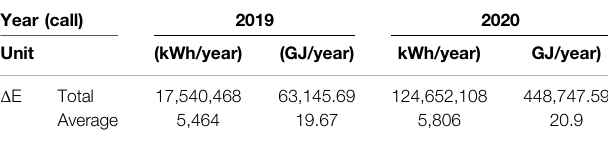
TABLE 6 | Potential change in electricity production in the power plant for a year - the results of calculations.